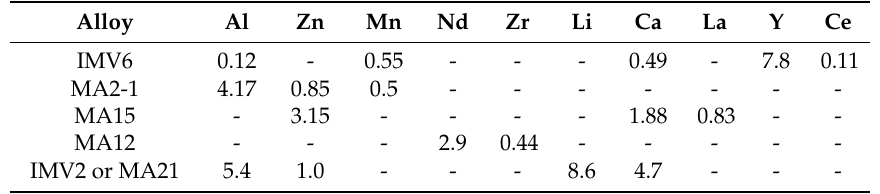
Table 9. Mechanical properties at room temperature and − 135 °C [28].